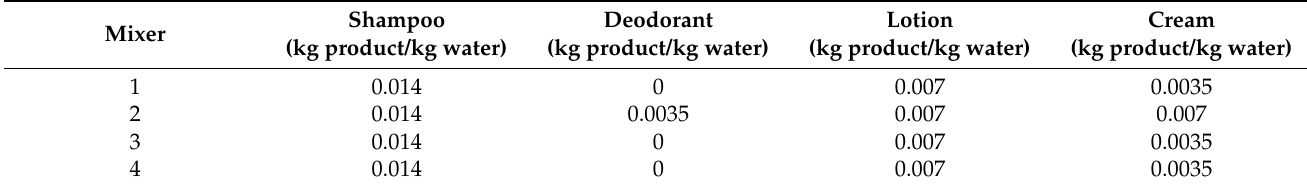
Table A12. Maximum allowed inlet contaminant concentration for case study 4